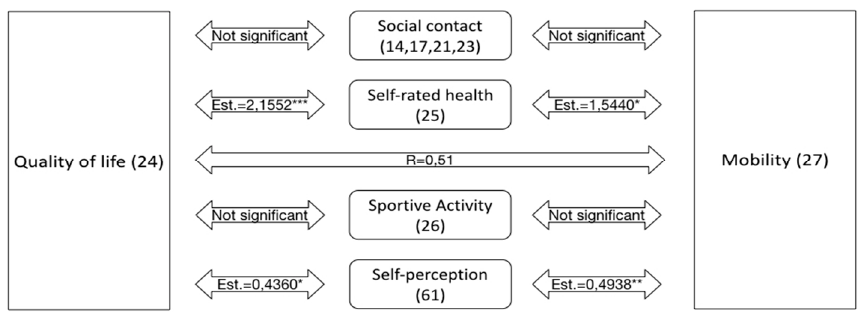
Figure 2. Interaction of the independent variables “Mobility” and “Quality of life” with the selected parameters. All four sub-questions of “Self-perception” are significant (the highest significance is indicated: * p < 0.05, ** p < 0.01, *** p < 0.001).